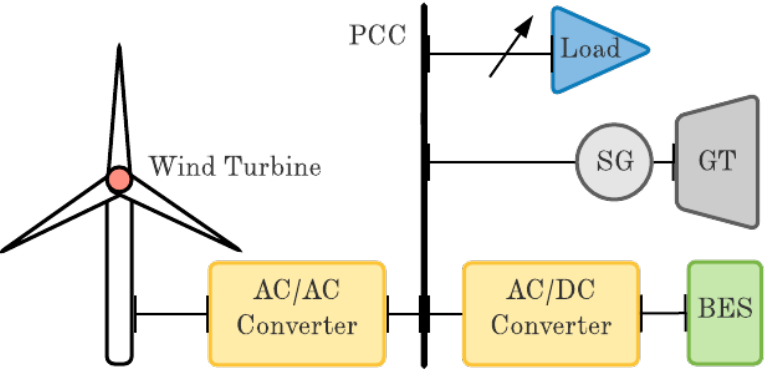
Figure 1. Representation of the microgrid model for the case study. The arrow indicates a vari- able